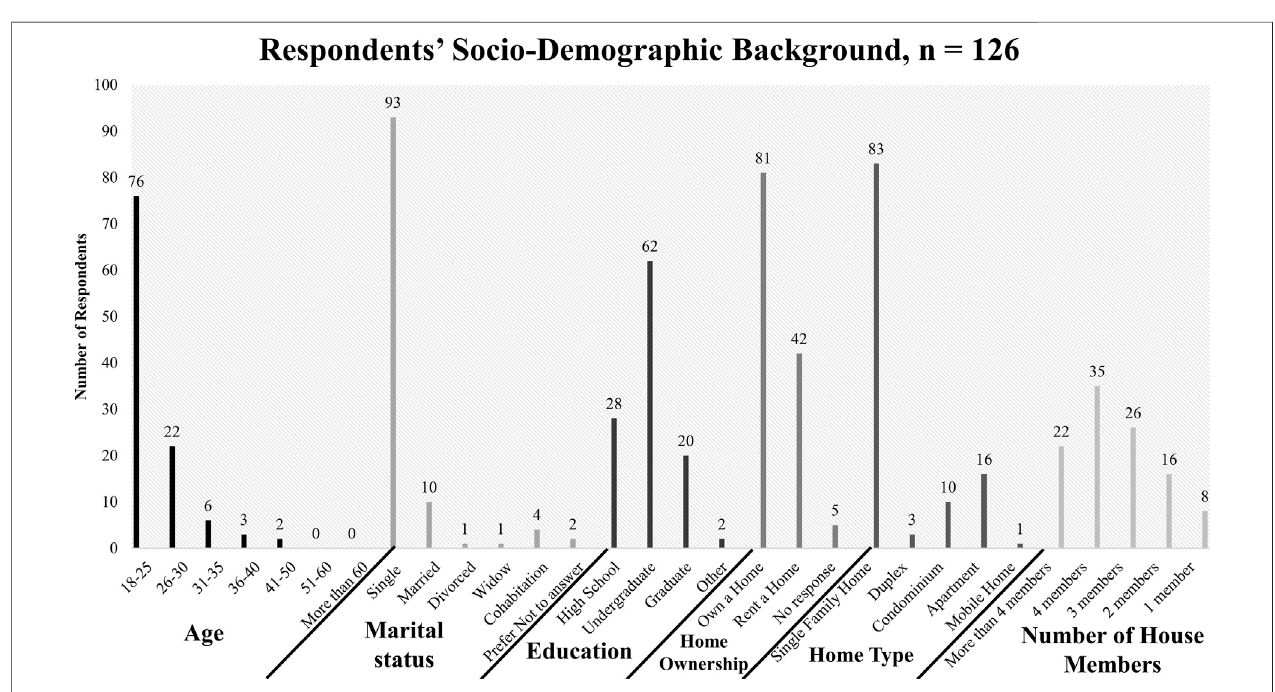
FIGURE 4 | Respondents ’ Socio-Demographic and Background Data, n =